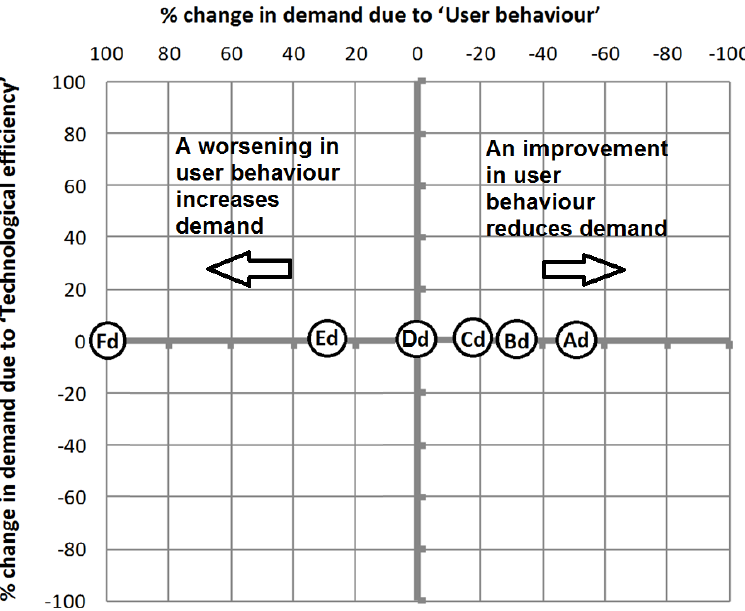
Figure 2. Domestic demands through behavioural change (Futures Framework